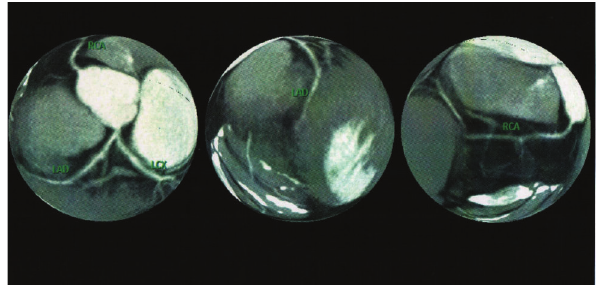
Figure 7: CT coronary angiography. There is no significant stenosis in the coronary